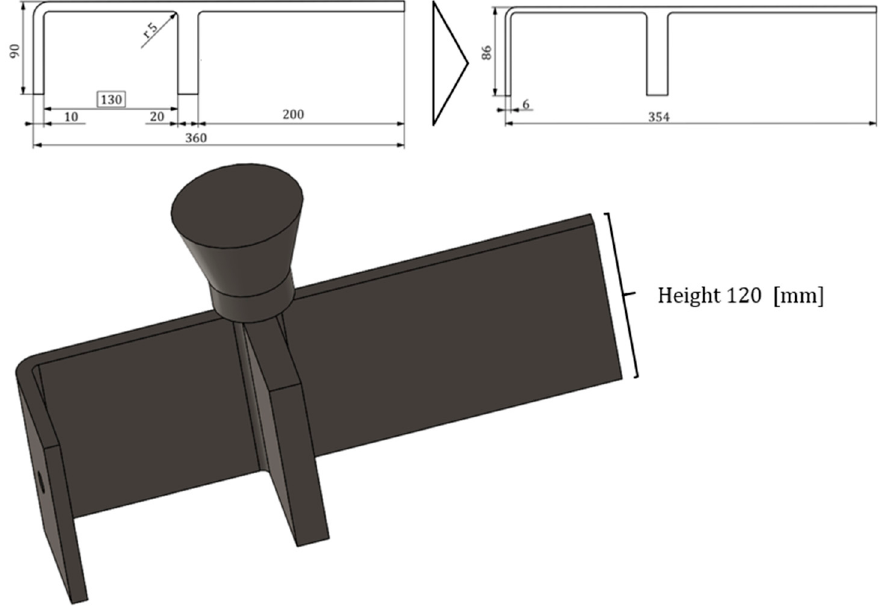
Figure 2. On the top left, the geometry parameters for the test specimen with initial wall thickness and on the top right with its thin-walled configuration. On the bottom a CAD-model of the complete cast part with inlet-feeder.